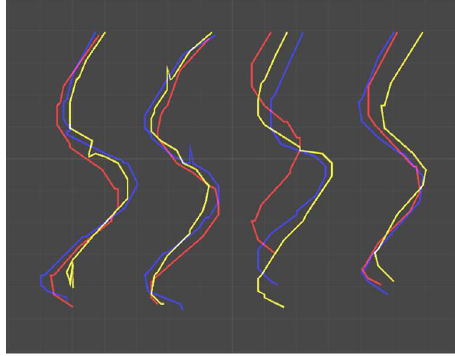
Fig. 24 No warning vs warning; order of experiment: